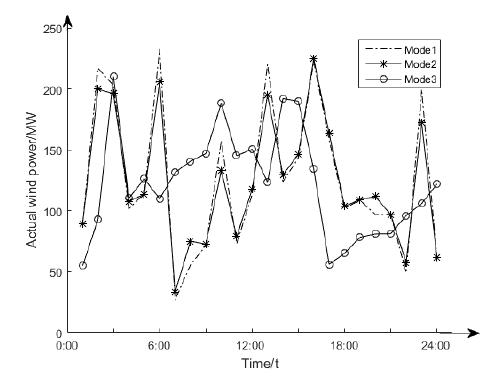
Figure 4. Actual output of wind power in three